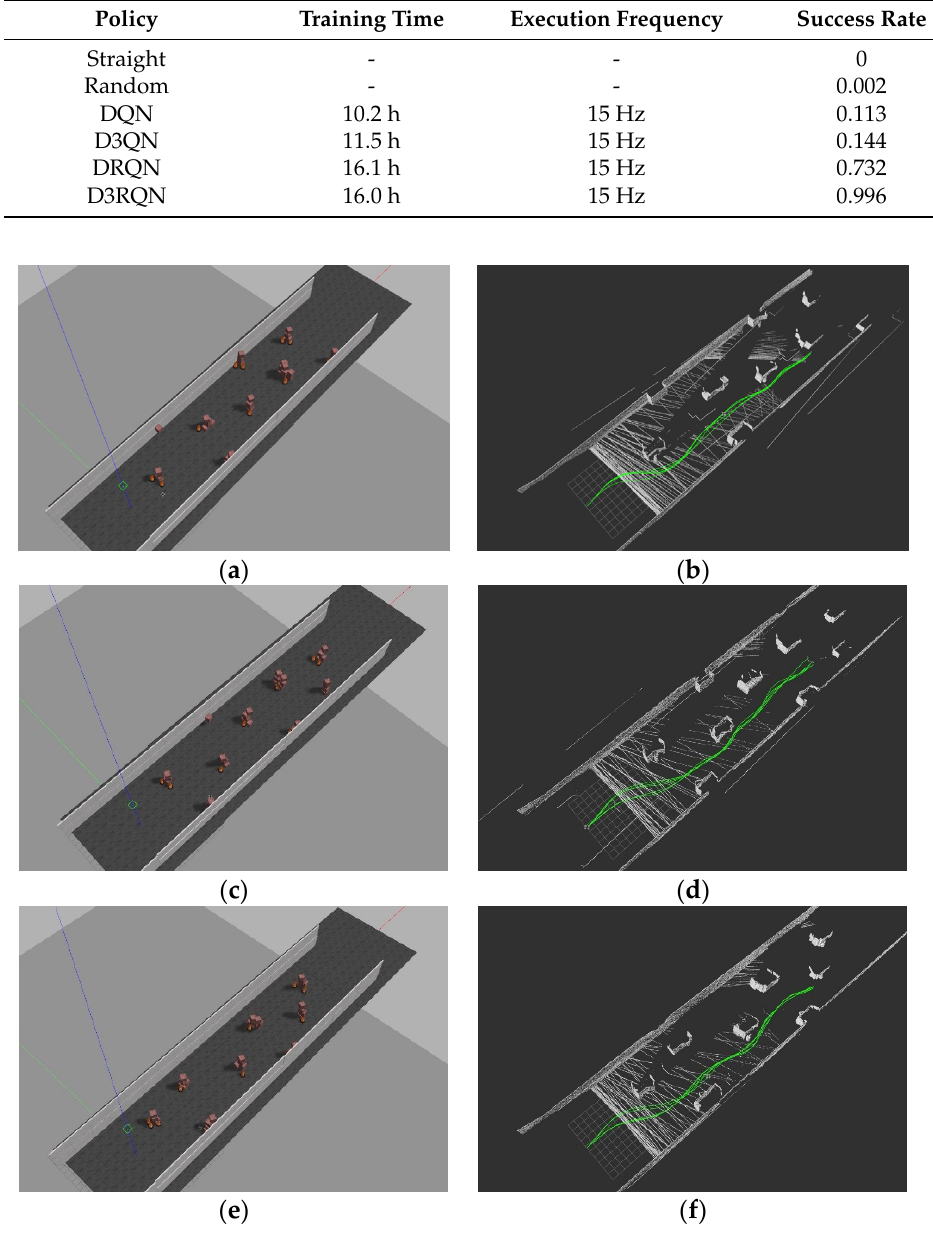
Figure 14. The test scenarios and corresponding success trajectories. ( a ) Test scenario 1, ( b ) Trajectory in scenario 1, ( c ) Test scenario 2, ( d ) Trajectory in scenario 2, ( e ) Test scenario 3, ( f ) Trajectory in scenario 3.